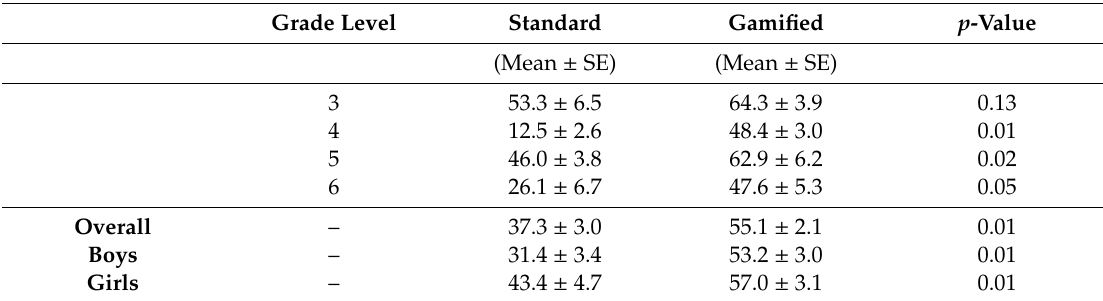
Table 1. Average student moderate-to-vigorous physical activity participation outcomes for all classes combined, by grade level and gender, for the last week of the standard and gamified intervention. Percent of Students in Moderate-to-Vigorous Physical Activity (MVPA) during an Activity Break Grade Level